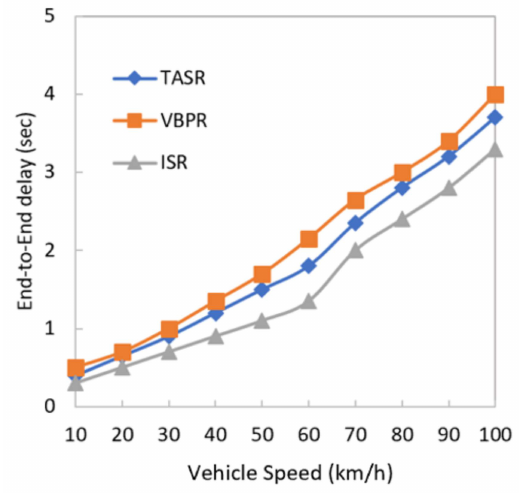
Figure 10. Comparison of end-to-end delay with increasing vehicle